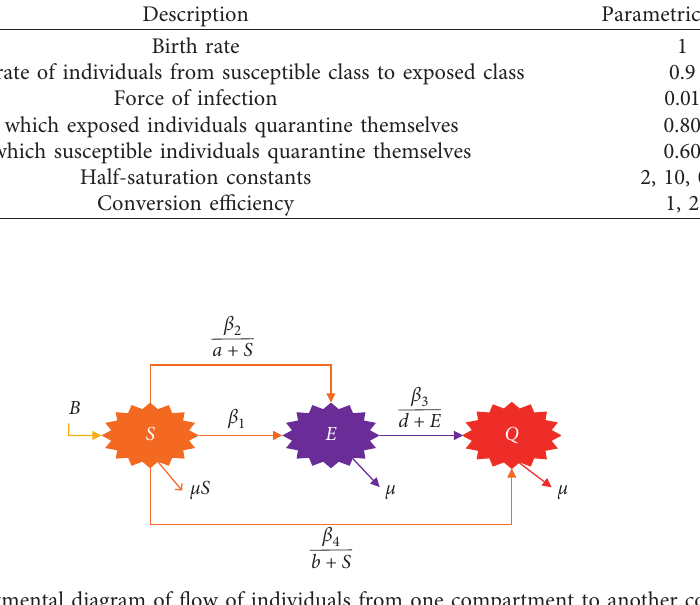
Figure 1: Compartmental diagram of flow of individuals from one compartment to another